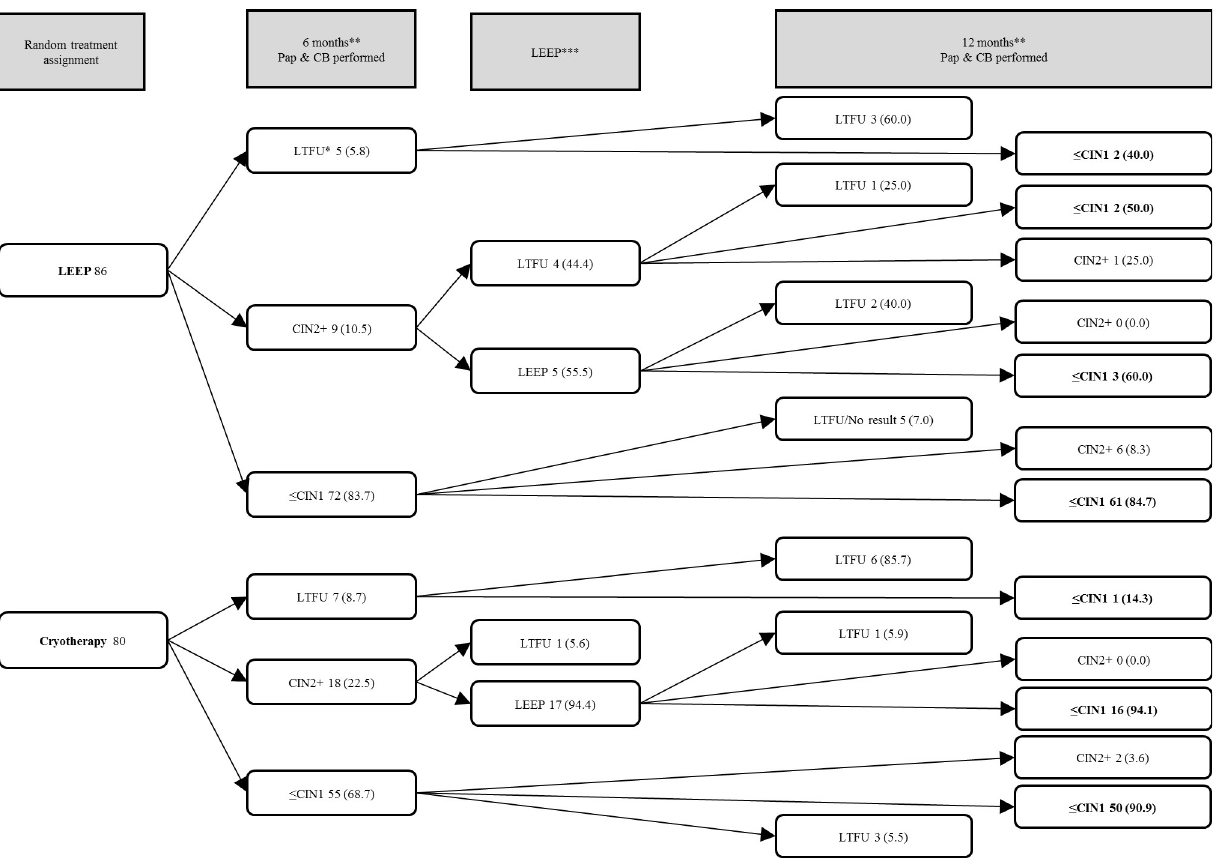
Fig 1. Treatment assignment, 6- and 12-month follow-up rates and outcomes for HIV-positive women receiving LEEP or cryotherapy for CIN2+ in a clinical trial in Johannesburg, South Africa (n (%)) [17]. CB = colposcopic biopsy; Pap = conventional cytology; CIN = Cervical intraepithelial neoplasia; CIN2+ = CIN level 2 or greater; � CIN1 = No disease or CIN1; LTFU = lost to follow-up. � Women could be LTFU at 6 months, indicating a missed visit, for their LEEP appointment after the 6-month visit, or at 12 months, meaning that no outcome was obtained at 12 months. In the clinical trial [17] and the as-treated analysis, women were censored if they were pregnant, formally left the study, or died. In the intention-to-treat analysis, women who were LTFU at 12 months were classified as treatment failures. �� Colposcopic biopsies and conventional cytology were performed at six and 12 months to evaluate the presence of disease. ��� At 6 months, LEEP was performed for women with CIN2+ (unless the woman did not return for treatment or was pregnant) regardless of the initial treatment assignment.